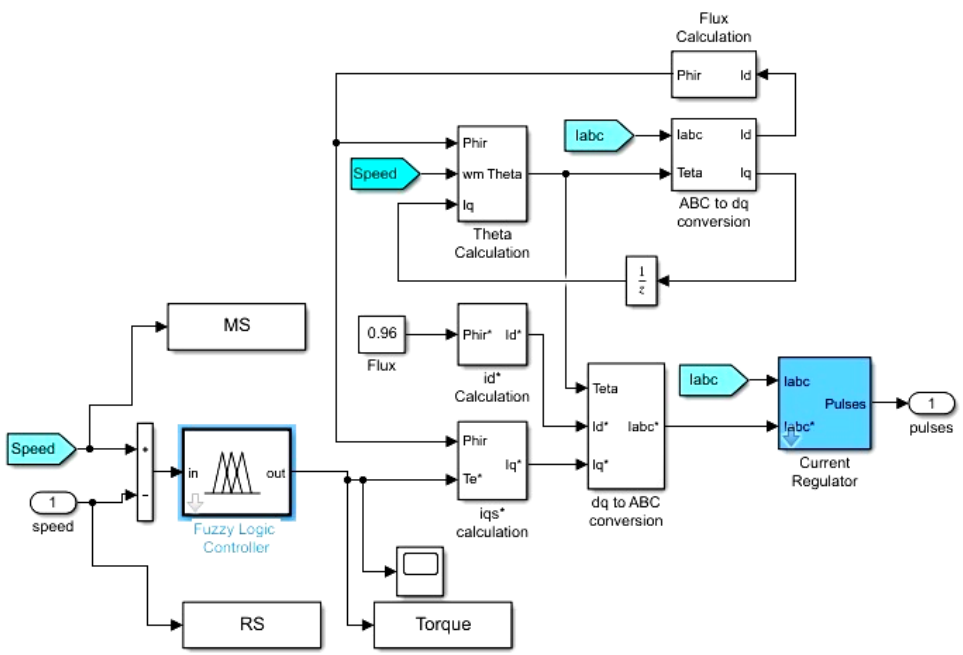
Figure 5. Simulink model of fuzzy logic controller–based vector